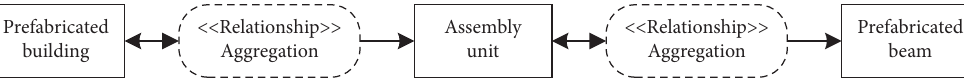
Figure 11: Example of BIM-based data integrated database schema structure.